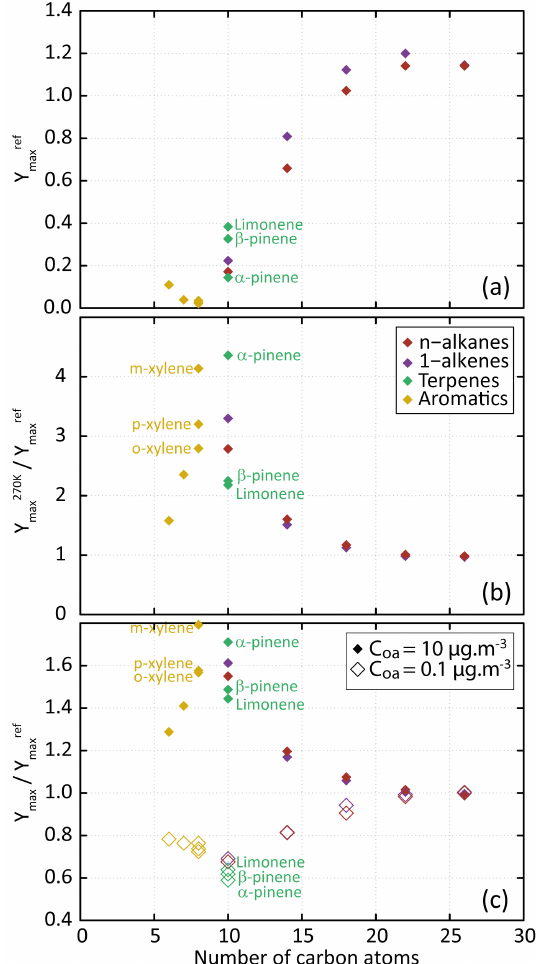
Figure 3. (a) Dependence of Y max on the precursor’s carbon num- ber for the scenario performed at a temperature of 298K, a zenith angle of 50 ◦ , a C oa of 1µgm − 3 , 40ppb of ozone and a RRR of 90%. (b) Dependence of Y 270K max /Y ref max on the precursor’s carbon − 3 ref number. (c) Dependence of Y 0 . 1µgm max /Y max (open symbols) and − 3 ref Y 10µgm max /Y max (filled symbols) on the precursor’s carbon num- ber.